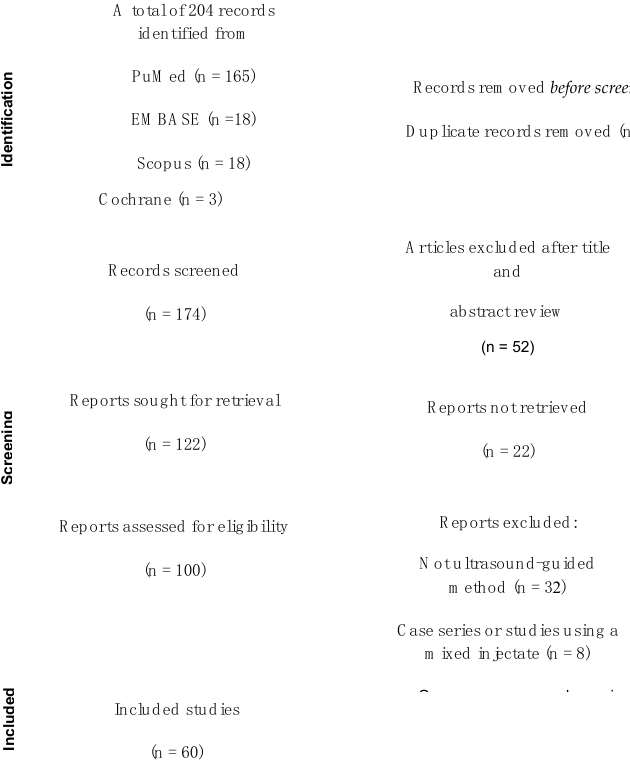
Figure 1. PRISMA flow diagram showing the selection of studies.